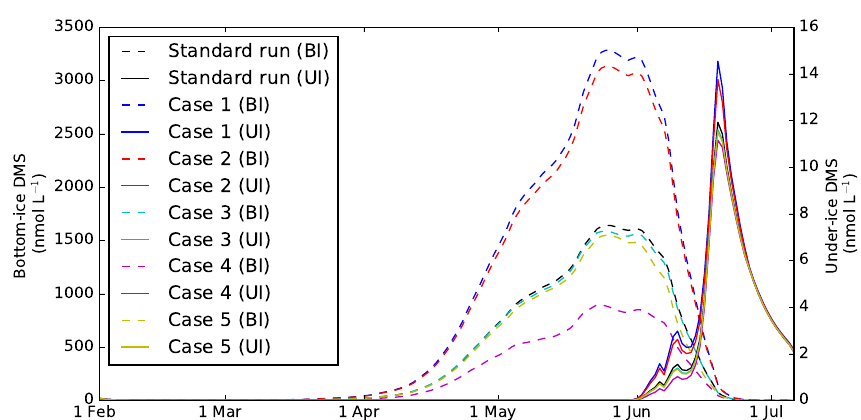
Figure 7. Simulated time series of bottom-ice (BI) and under-ice (UI; 0.5m below the ice) DMS concentrations (nmolL − 1 ) during 2010 for the standard run; Case 1, doubling the intracellular DMSP:Chl a ratio; Case 2, doubling the DMS yield fraction; Case 3, doubling the bacterial DMSPd consumption rate constant; Case 4, doubling the bacterial DMS consumption rate constant; and Case 5, doubling the photolysis rate constant.